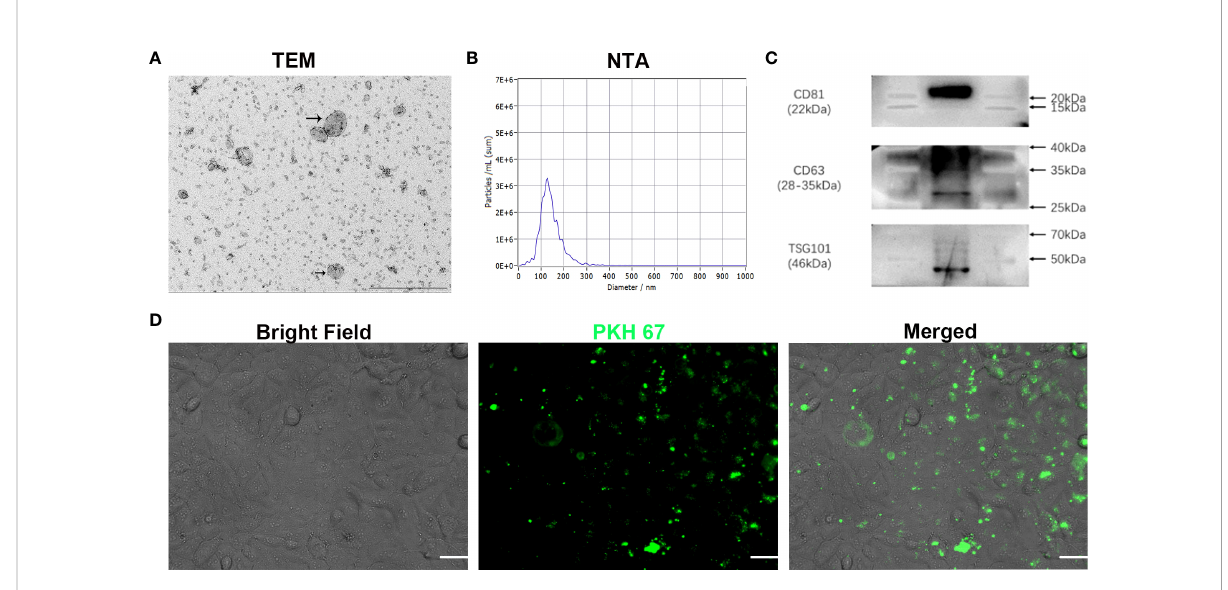
FIGURE 2 Characterization of exosomes extracted from conditioned medium of OSCC cells in vitro . (A) The morphology of exosomes was observed using transmission electron microscopy (TEM). Scale bar = 500 nm. (B) Particle size distribution of exosomes assessed by nanoparticle tracking analysis (NTA). (C) Expression of exosome-speci fi c CD81, CD63 and TSG101 validated by Western blot analysis. (D) Ef fi cient uptake of PKH 67- labeled exosomes (green) by HUVECs detected at 24 h. Bright Field shows OSCC cells. Scale bars = 20 m